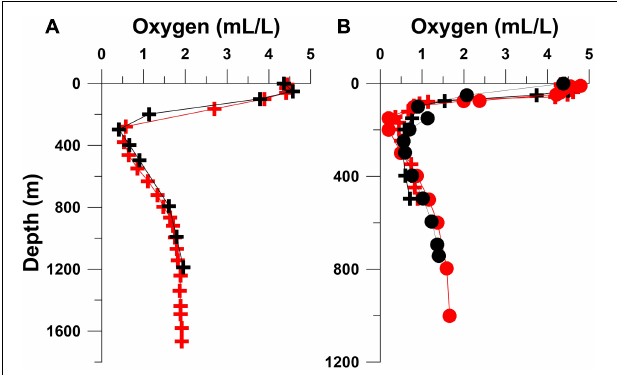
FIGURE 3 | Comparison of oxygen profiles from selected Sagar Kanya (SK) stations with those from nearby stations occupied during other cruises: (A) SK Station 40 (black crosses) sampled on May 24, 1983 with GEOSECS Station 407 (red crosses) sampled on December 22, 1977; (B) SK Station 70 (black circles) sampled on May 29, 1983 with Tyro Station 1 (red circles) sampled on May 27, 1992, and SK Station 74 sampled on May 29, 1983 (black crosses) with Tyro Station 2 (red crosses) sampled on February 03, 1993. See Figure 1 for station locations.